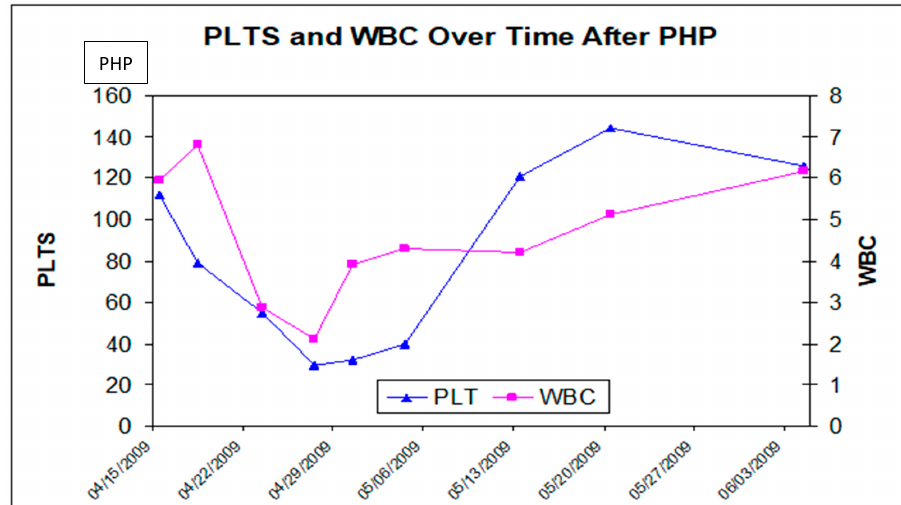
Figure 3. Peri- and post-operative hematological toxicity in an explanatory PHP case. The prolonged partial thromboplastin time (aPTT) was an intended outcome from heparin anticoagulation required to perform hemofiltration. Plasma proteins, such as albumin and certain coagulation factors, were also removed by the filters, but they were typically corrected by the administration of fresh frozen plasma and/or cryoprecipitate at the end of the